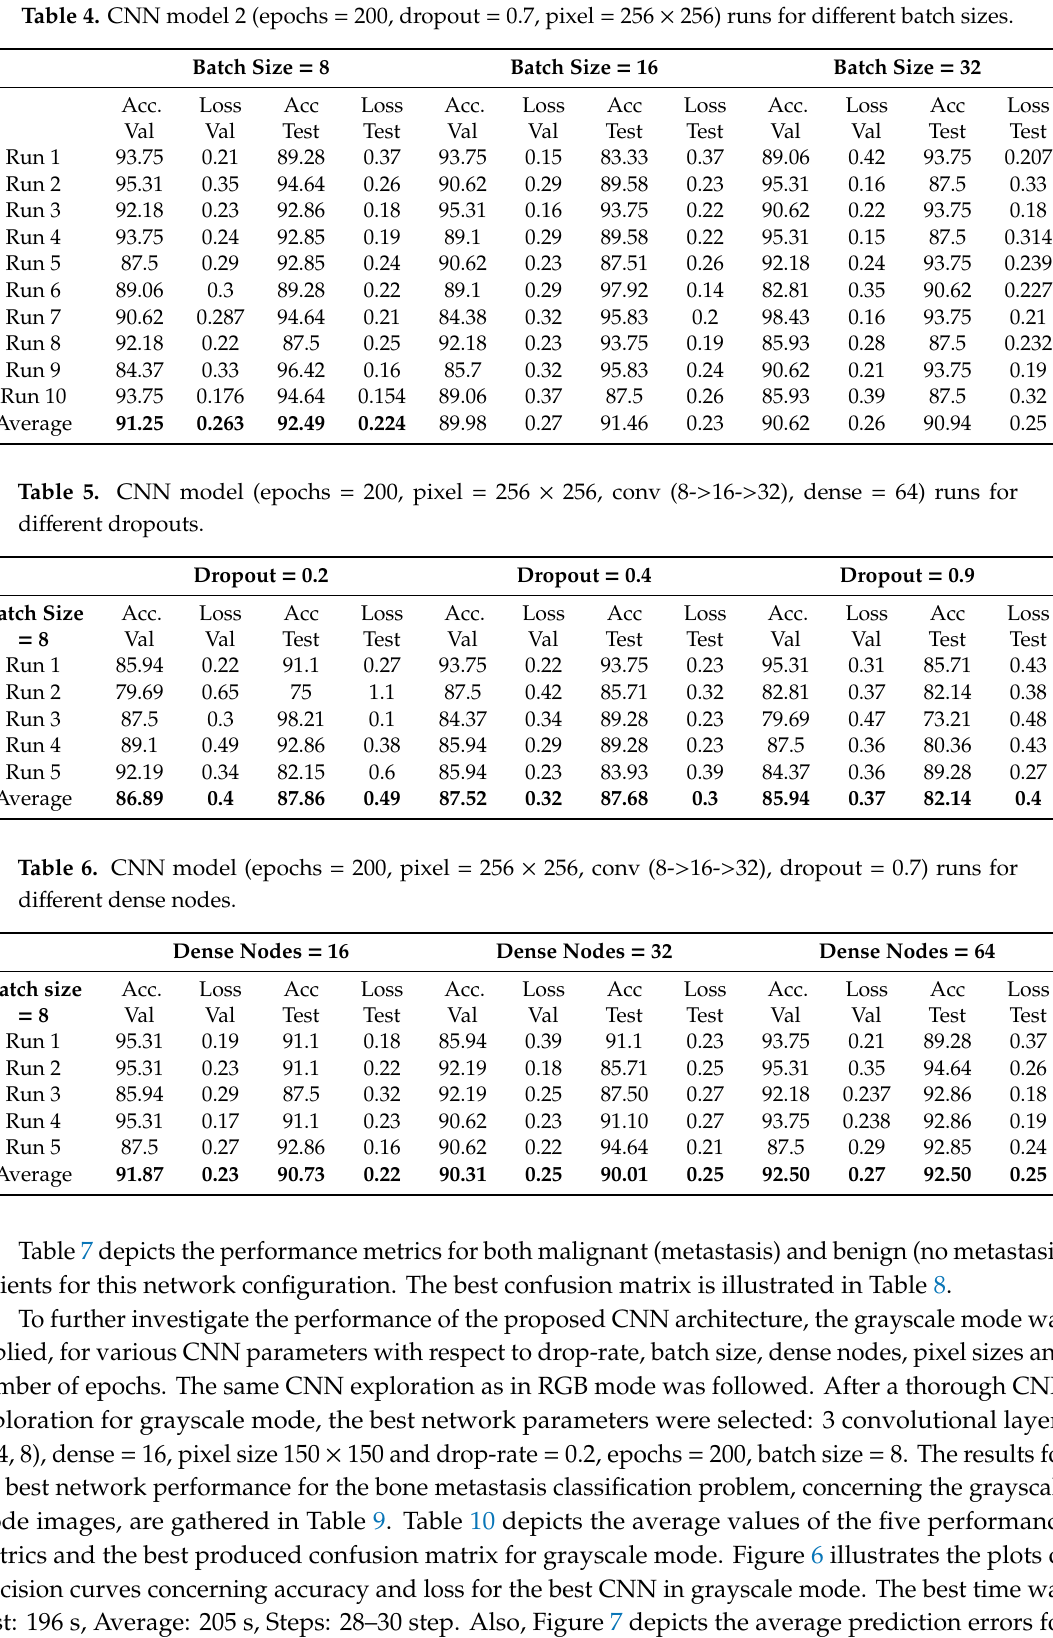
Best: 196 s, Average: 205 s, Steps: 28–30 step. Also, Figure 7 depicts the average prediction errors for the examined CNN architectures in RGB and Grayscale mode, showing the outperformance of the best CNN architecture with dropout =